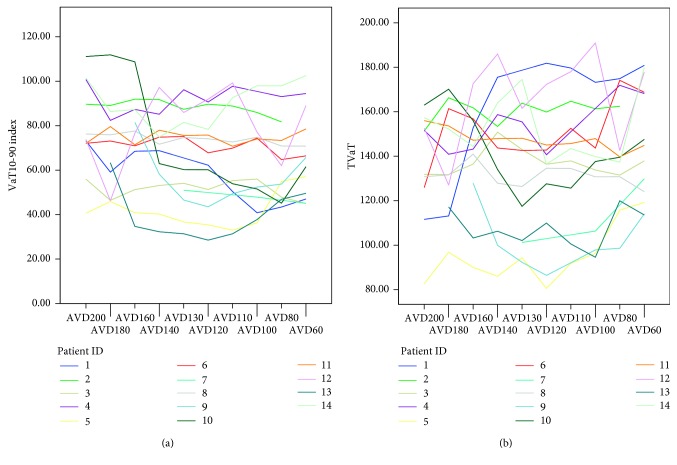
VaT10-90 and TVaT values in each patient versus the AVD setting. AVDXXX, atrioventricular delay at XXX milliseconds; TVaT, total ventricular activation time; VaT10-90 index, ventricular activation time between percentile 10 and 90 obtained.